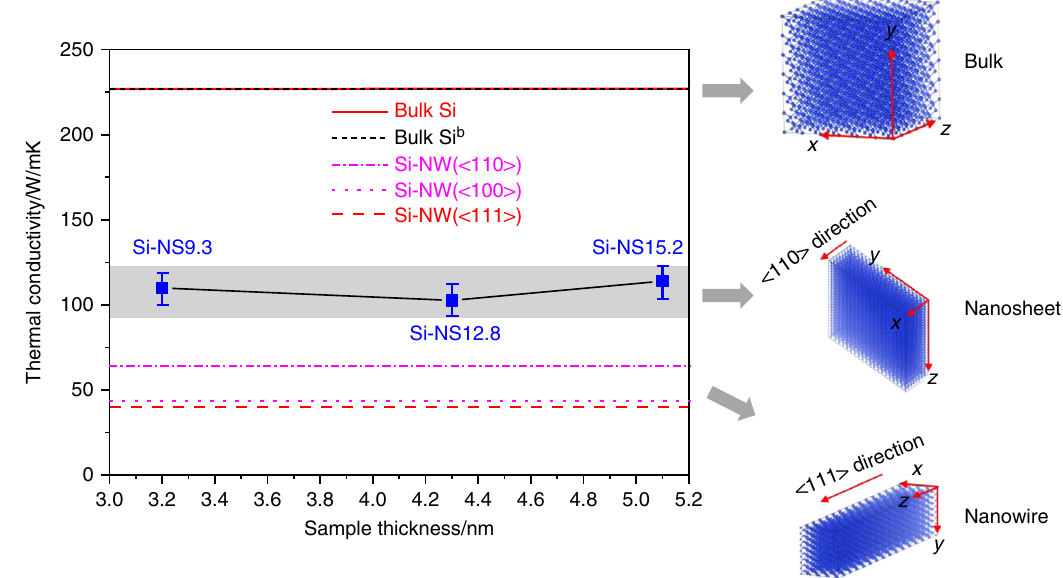
Fig. 7 Calculated thermal conductivity of bulk silicon and Si-nanostructures. The thermal conductivity of bulk Si, bulk Si b (predicted by Zhou 62 ), <111> direction Si-NW, <110> surface Si-NW (predicted by Zhou 62 ), <100> direction Si-NW (predicted by Donadio 63 ), Si-NS9.3, Si-NS12.8, and Si-NS15.2. Gray area is the fl uctuant range of the thermal conductivity for nanosheets. The model systems studied in this work for bulk silicon, silicon nanosheet with <110> zone axis orientation, and silicon nanowire of which the large dimension is along <111> direction, are shown as